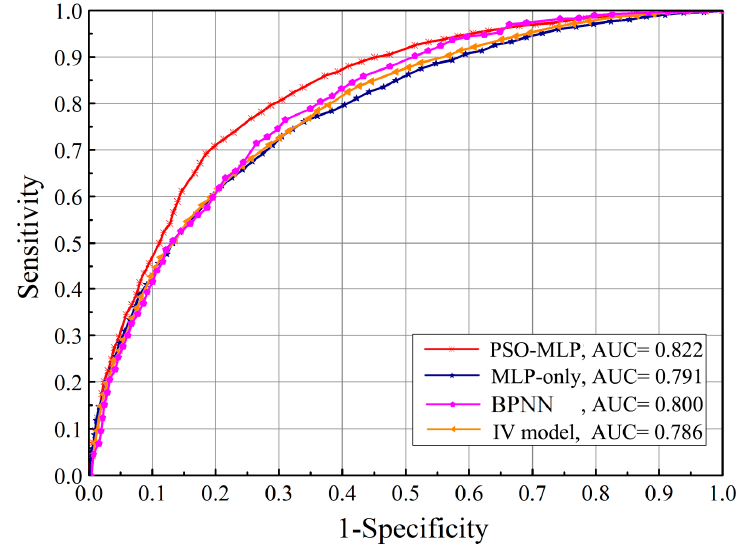
Figure 7. ROC curves of the four models for LSP.